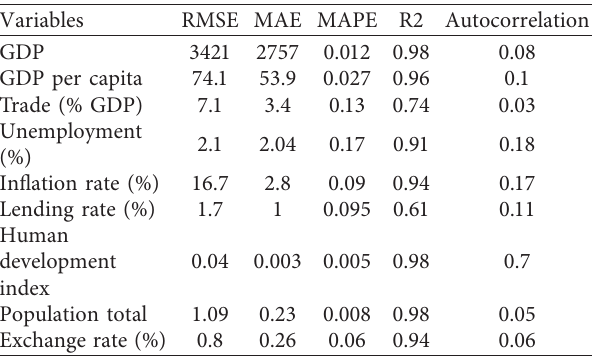
Table 4: Arima model accuracy for independent variables’ prediction.